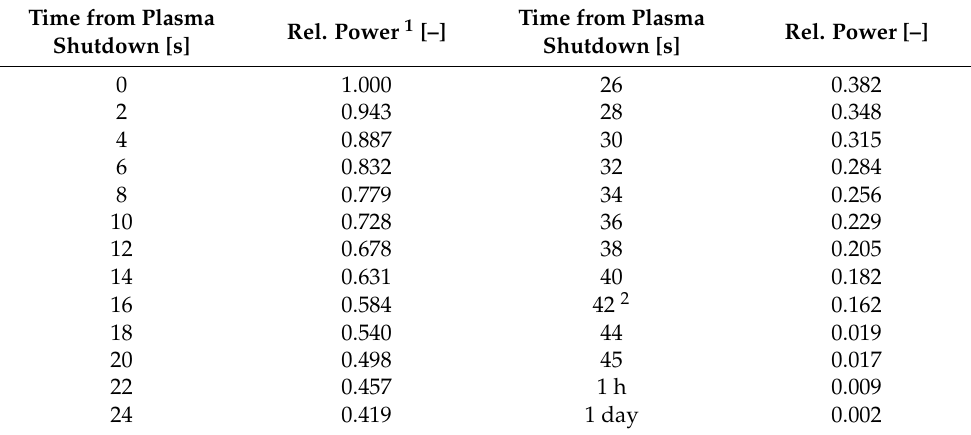
Table 6. Plasma ramp-down curve: tabulation of relative power values vs